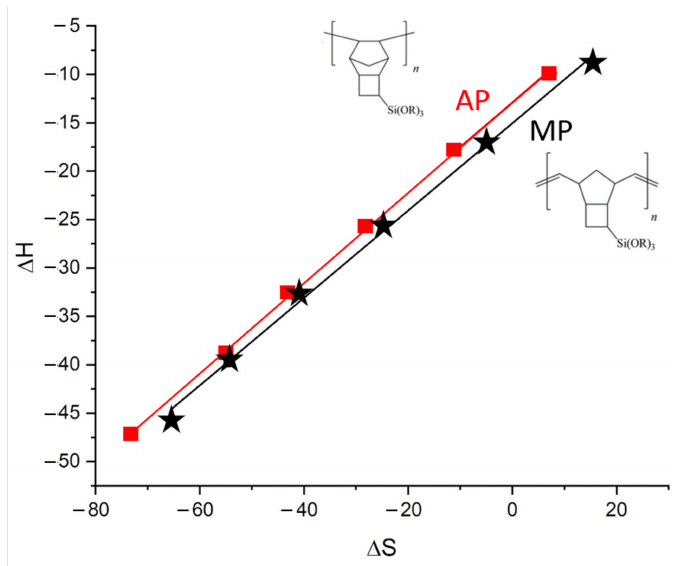
Figure 6. Compensation plots for the sorption of n-alkanes during the AM and PM stationary phases.